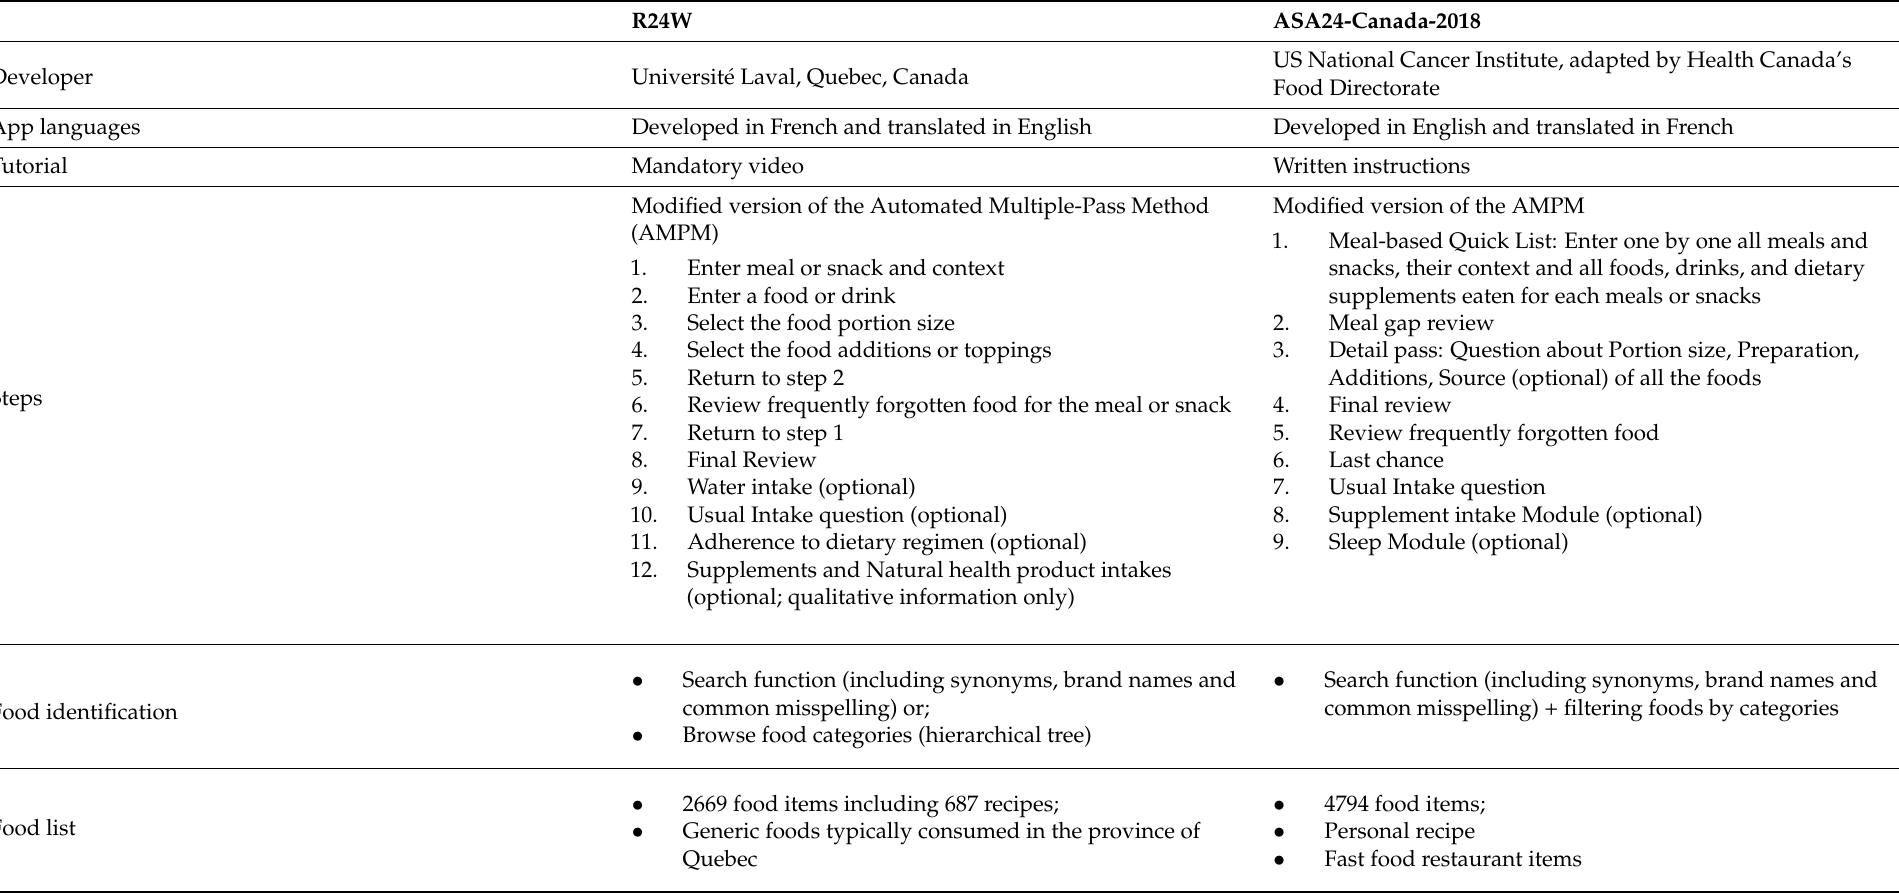
Table 1. Comparison of the Characteristics of the Respondents Website of the R24W and the